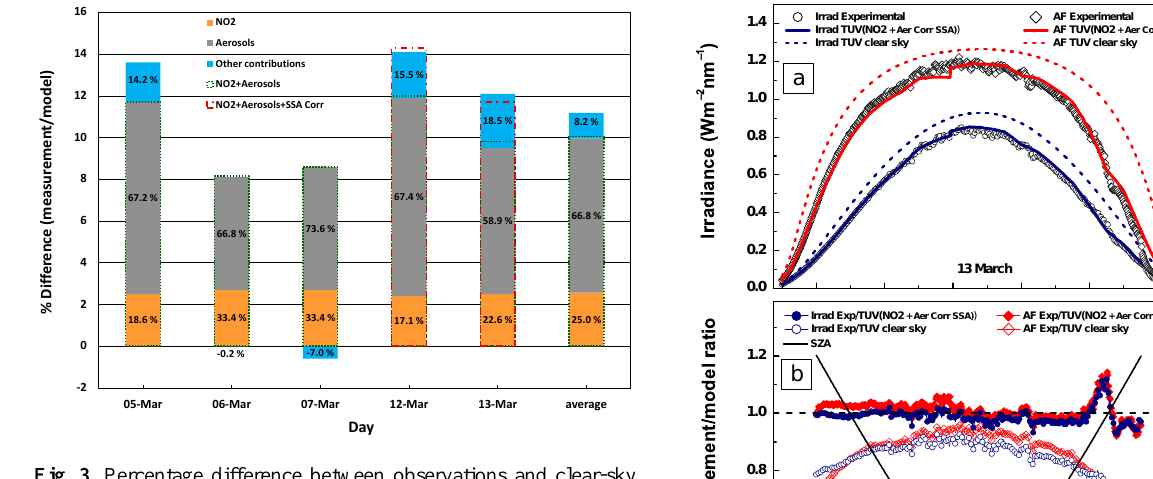
Fig. 3. Percentage difference between observations and clear-sky model calculations of the daily-integrated actinic flux. Different colors correspond to the contribution of NO 2 , aerosols, and other sources to these differences. Dotted (green) lines show the effect of including both NO 2 and aerosols in the model. Dashed lines (red) show the results when SSA is corrected.